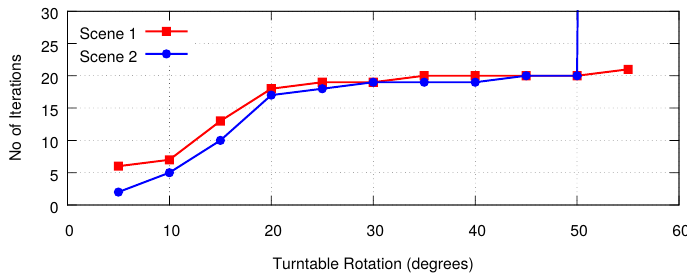
Figure 9. Number of iterations required by the ICP-BD algorithm in two scenes shown in Figure 5 of